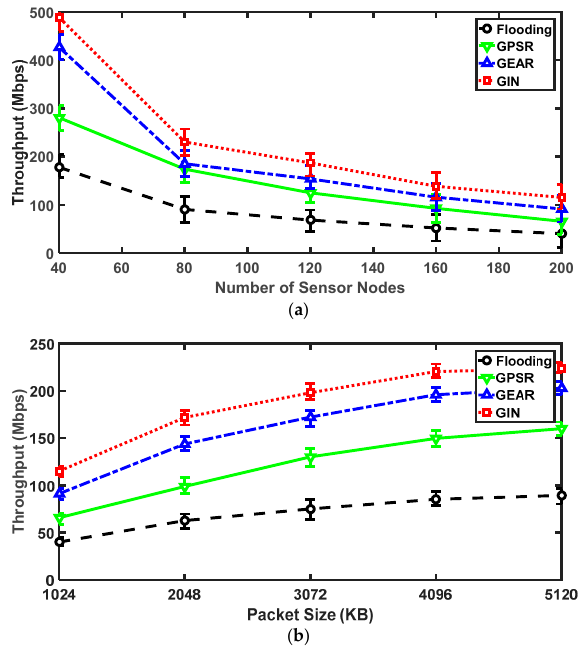
Figure 11. The results for GIN in throughput. ( a ) Relationships between the throughput and the number of sensor nodes; ( b ) Relationships between the throughput and the packet size.